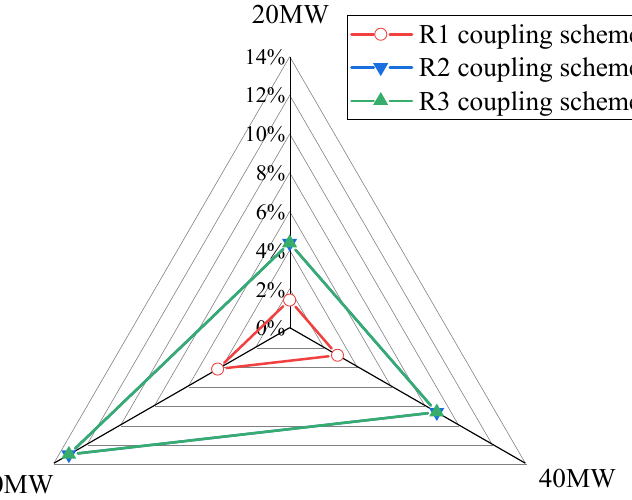
Figure 8. Peak regulating depth of the coupled system in the exothermic process.